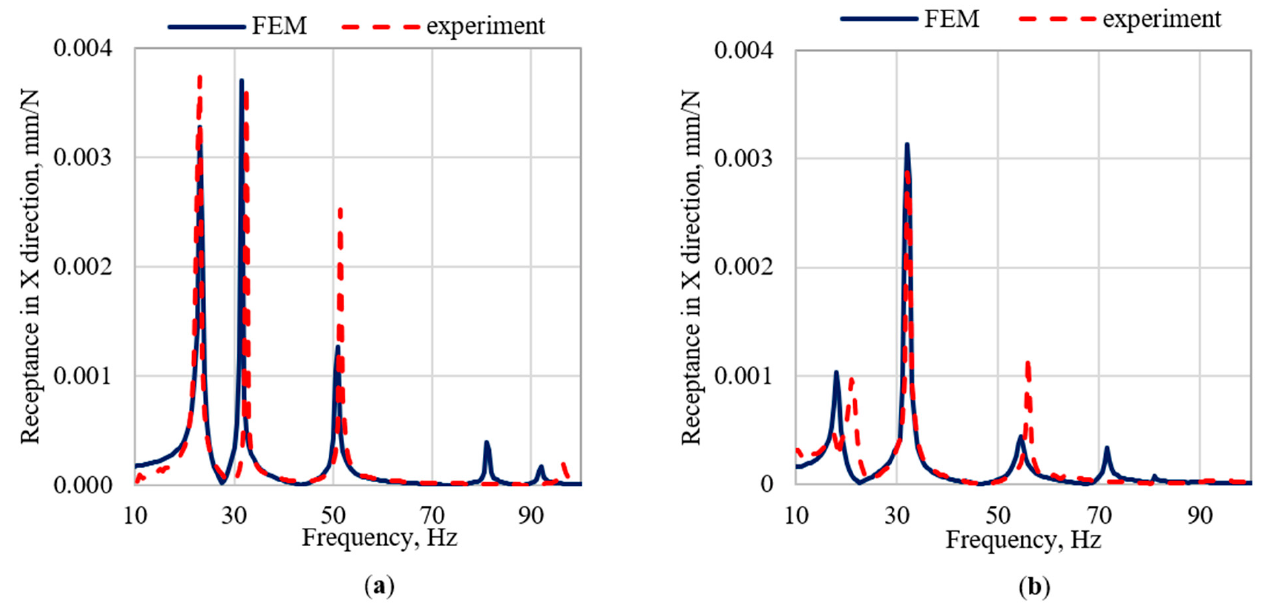
Figure 5. Comparison of selected receptance functions in X direction ( a ) for the frame and ( b ) for the frame with the robot.